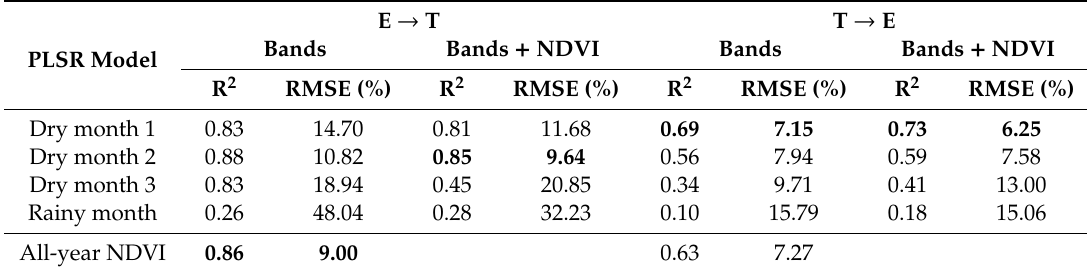
Table A2. R 2 and RMSE of the PLSR for the integrated models including Ethiopia and Tanzania (Scenario 2). E → T indicates that training data are taken from Ethiopia and validated on Tanzania, while T → E indicates training data from Tanzania validated on Ethiopia. The two best performing models for each study site are marked in bold.